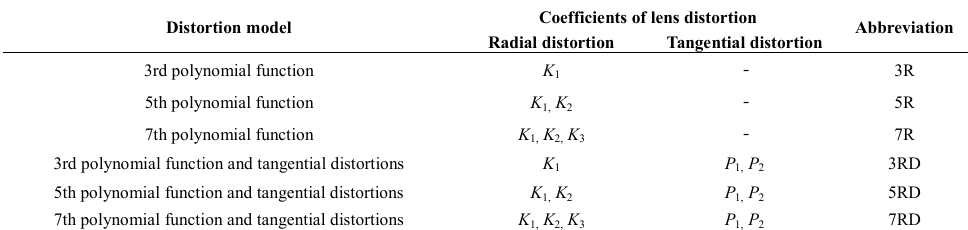
Table 2. Distortion model and its abbreviation (Wakutsu and Chikatsu,